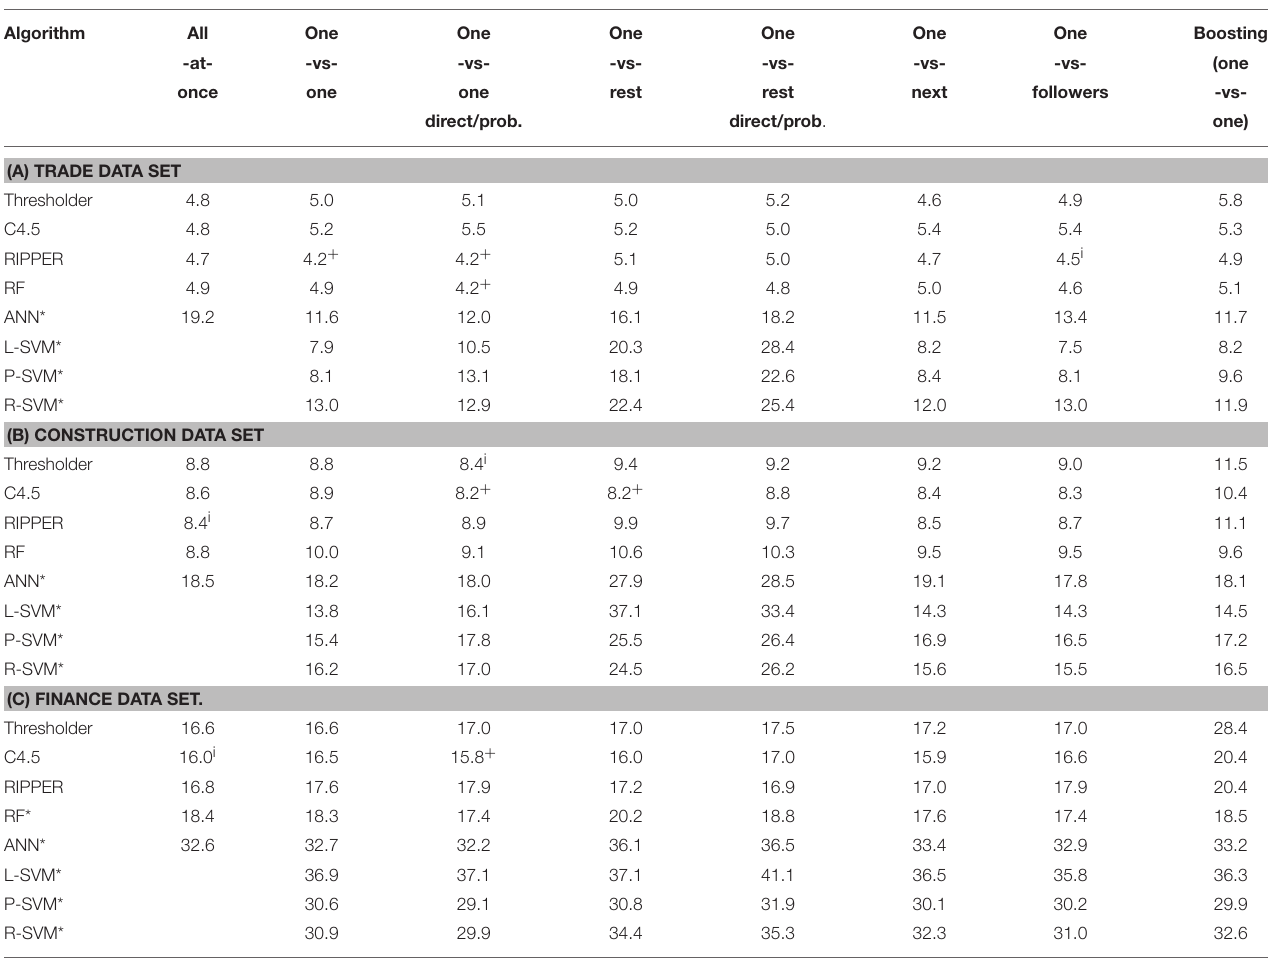
TABLE 5 | Error rates of learning algorithms and multiclass methods in percent.